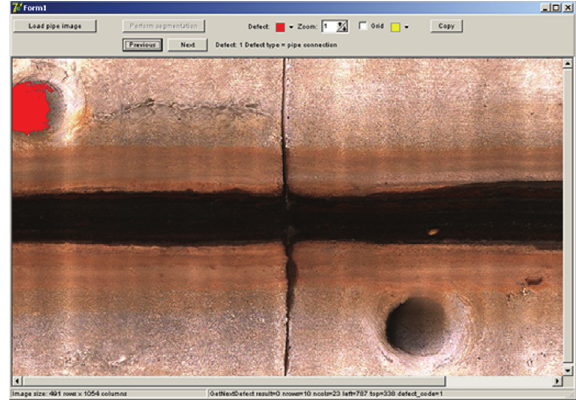
Figure 8: GUI display of pipe connection.